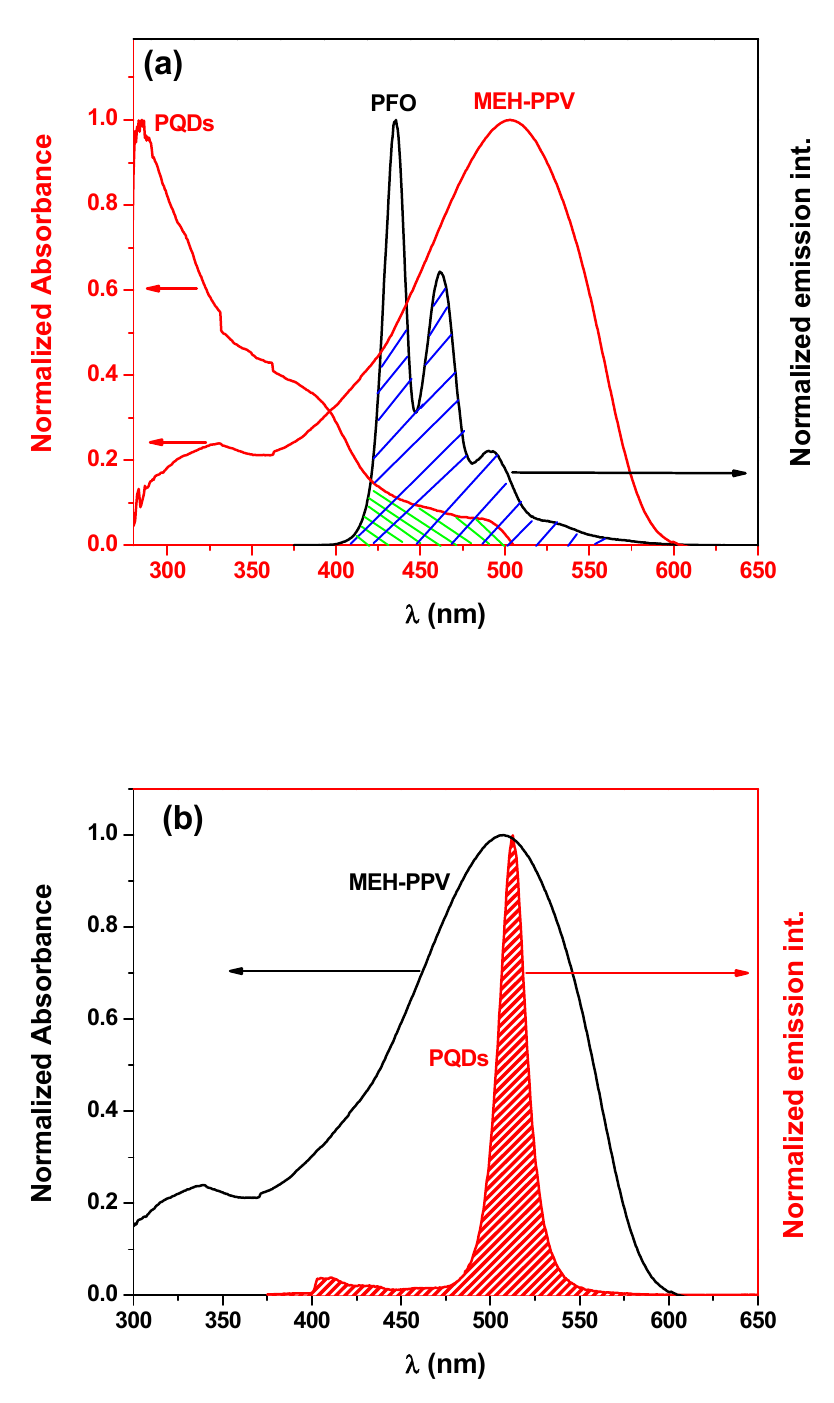
Figure 6. ( a ) Overlap between the emission spectrum of PFO with the absorption spectra of both the PQDs and MEH-PPV thin films, ( b ) overlap between the emission spectrum of PQDs and the absorption spectrum of the PFO thin fi lms.